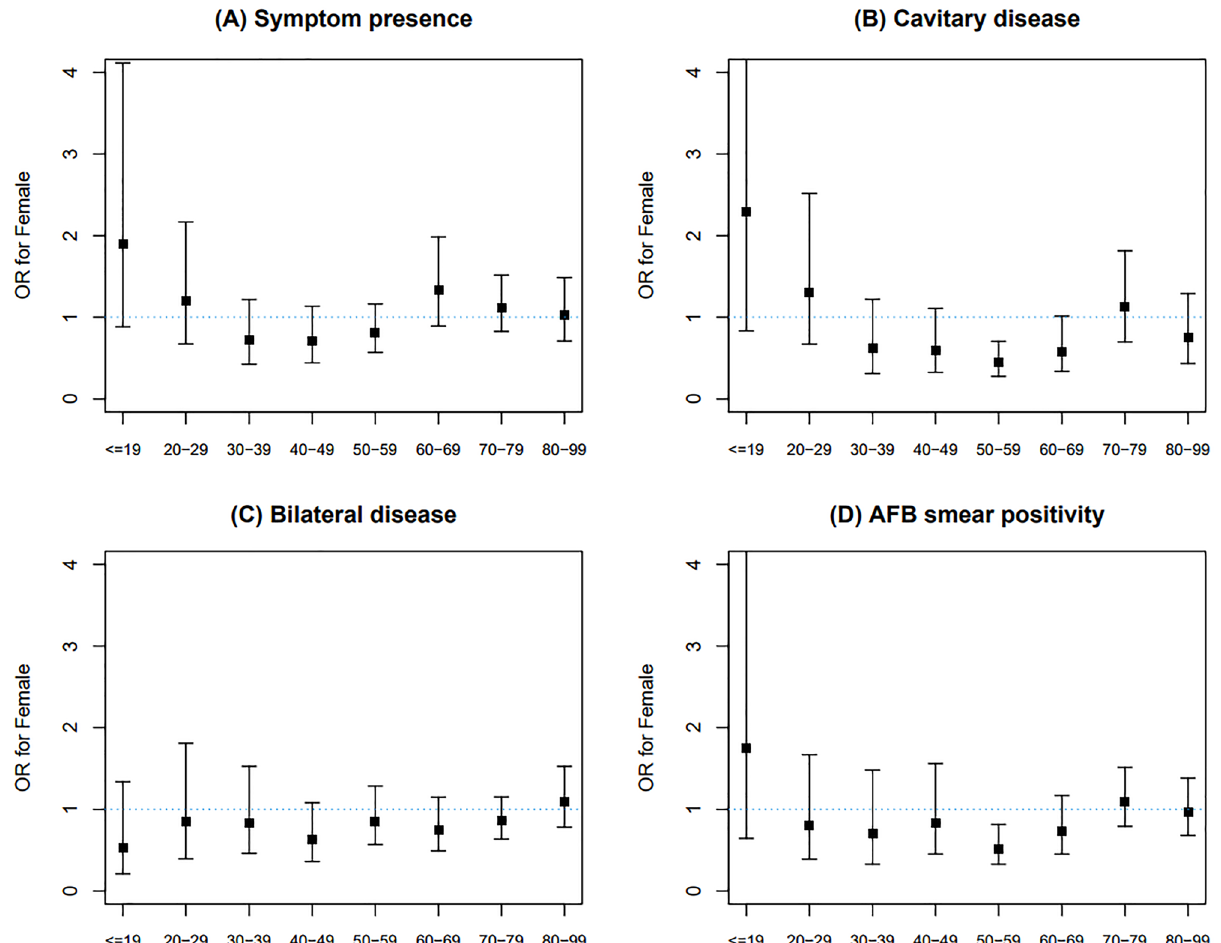
Figure 5. Multivariable analysis showing odds of disease severity of interest for female versus male in 10-year age increments: ( A ) symptom presence, ( B ) cavitary disease, ( C ) bilateral disease, and ( D ) AFB smear positivity. We assessed the odds of having extrapulmonary tuberculosis for females compared with males as a reference in every age category. The multivariable model was adjusted for age, sex, body mass index, current smoking status, heavy alcohol intake, and the presence of comorbidities. OR odds